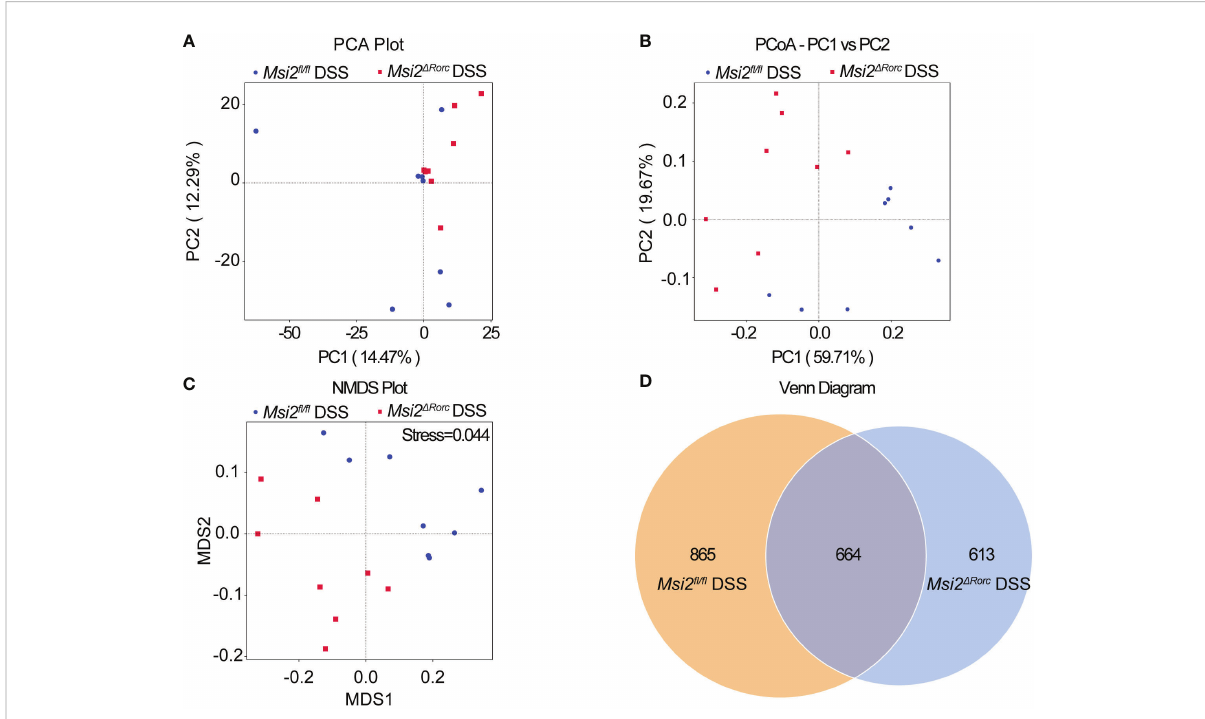
FIGURE 6 Comparison of the beta diversity index of the intestinal microbiota between the two groups. (A – C) PCA indicated a symmetrical distribution of the gut microbial community between the Msi2 fl / fl DSS group and the Msi2 D Rorc DSS group, which was also con fi rmed using PCoA and nonmetric NMDS. (D) Based on the ASV abundance, a Venn diagram analysis was performed and evaluated. Unique ASVs between the Msi2 fl / fl DSS group (orange) and the Msi2 D Rorc DSS group (blue) were identi fi ed, as well as common ASVs (brown) between the two groups (n=8).